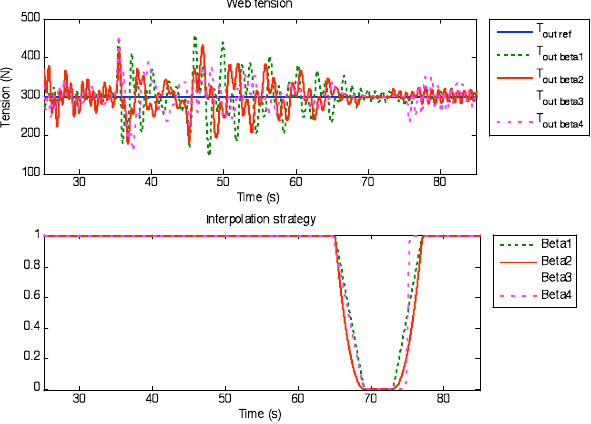
Fig. 14. Optimized PI controllers simulation results using cost function